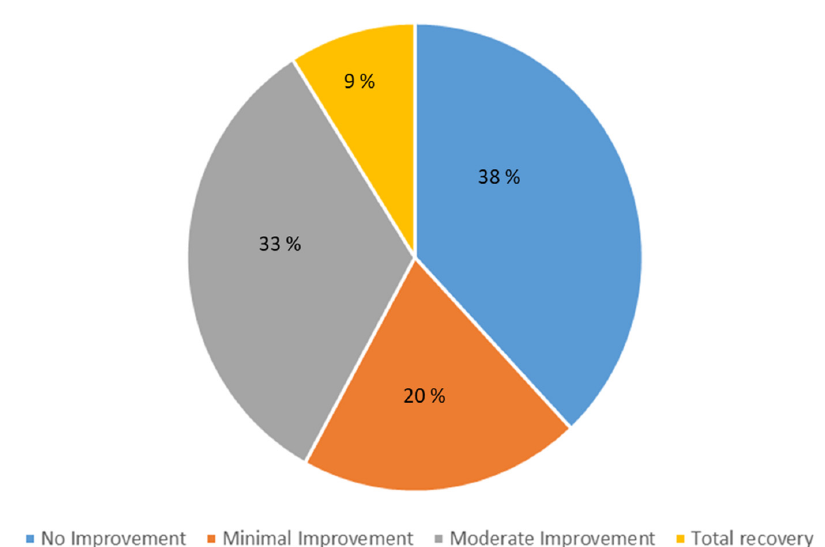
Figure 5. Patients’ perceived improvement.